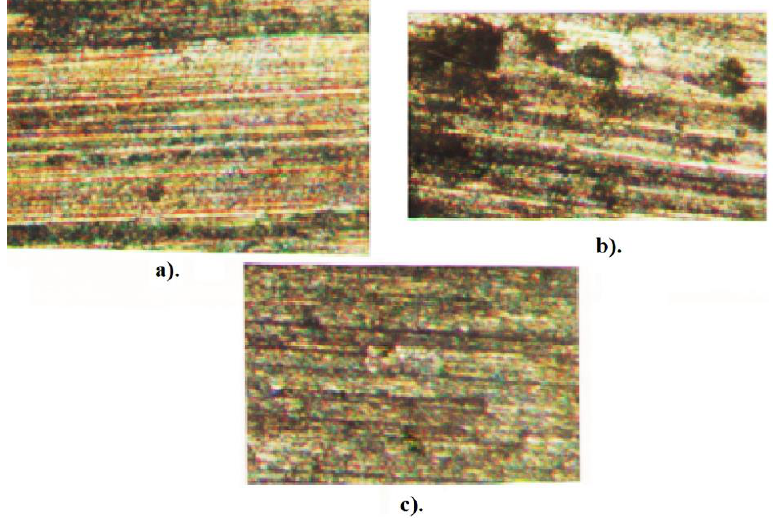
Figure 12. The topography of the manufactured surface: ( a ) workpiece hardness HB = 300; ( b ) workpiece hardness HB = 400; and ( c ) workpiece hardness HB = 200.